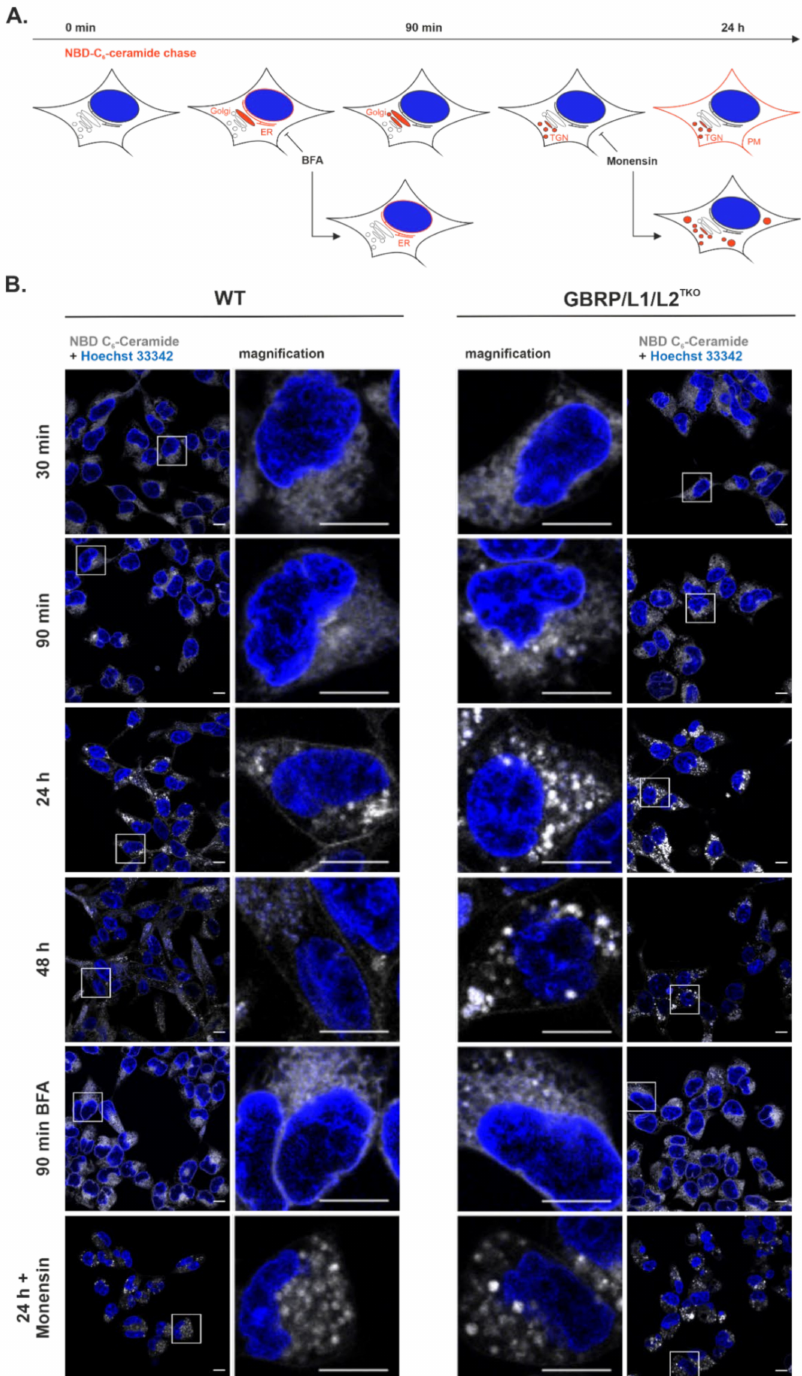
Figure 2. Intracellular ceramide distribution in WT and GABARAP/L1/L2 TKO cells. ( A ) Scheme representing the putative intracellular trafficking of NBD C 6 -ceramide (shown here in red) in WT cells, including sites of action of BFA and Monensin. ( B ) Live cell confocal fluorescence microscopy of WT and GABARAP/L1/L2 TKO cells labelled with NBD C 6 -ceramide (shown here in grey scale). After labelling for 1 h at 4 ◦ C, the cells were further incubated at 37 ◦ C for 30 min, 90 min, 24 h, or 48 h in full medium, or 90 min in full medium containing 10 µ M Brefeldin A (BFA), or 24 h in full medium containing 10 µ M Monensin. Nuclei were counterstained with Hoechst 33342. For each condition, one representative image from 5 individual experiments is shown. Scale bar, 10 µ